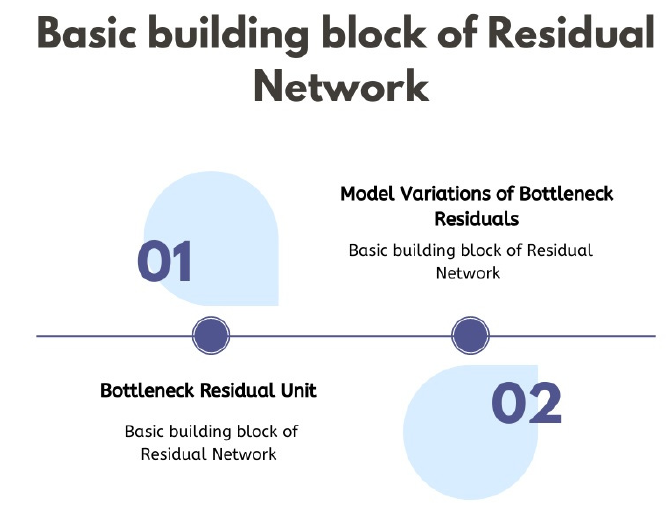
Figure 10. Basic Building Block of RDL Types.